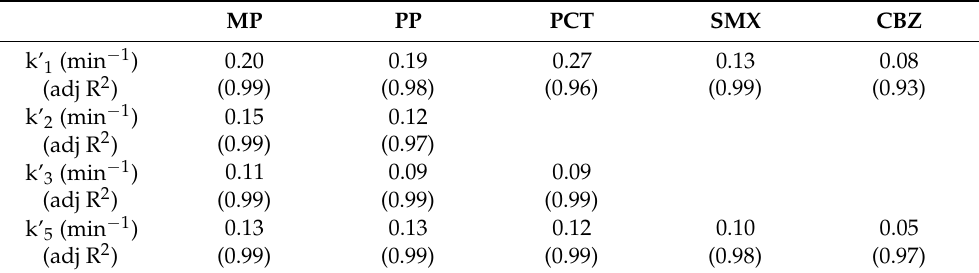
Table 3. Pseudo-first order kinetic rate constant of ozone-treated contaminants in MW (pH 7), in mixture, as function of time. (k’ 1 ) refers to the PPCP individually, whereas k’ 2 , k’ 3 , and k’ 5 , refer to Mix2, Mix3, and Mix5, respectively. Mix2 included MP and PP; Mix3 included MP, PP and PCT; Mix4 included MP, PP, PCT and SMX; and Mix5 included MP, PP, PCT, SMX and CBZ at 1 mg L − 1 each. The corresponding adjusted coefficients of determination (adj R 2 ) are also